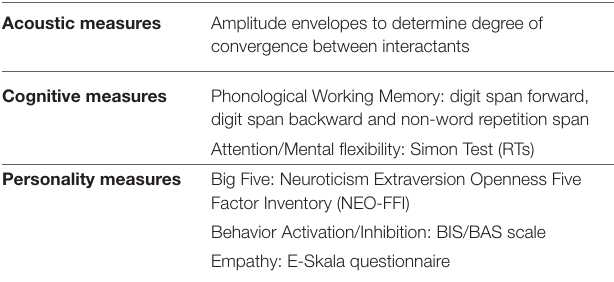
TABLE 1 | Overview of all tests contained in the convergence study (all measurements were supplied to the statistical models as continuous data). Acoustic